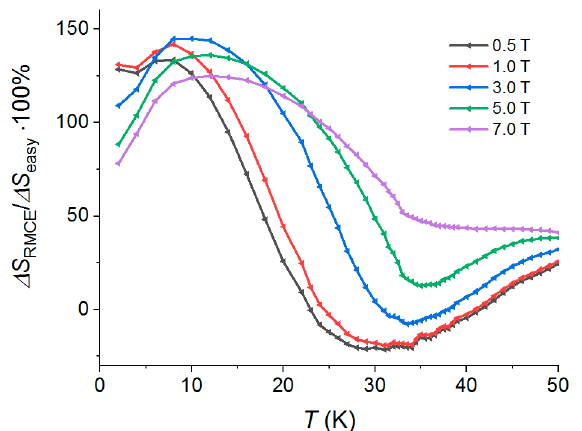
Figure 33. Percentage ratio between ∆ S RMCE and ∆ S easy (easy plane) for 11 as a function of temperature for different fields. Adapted with permission from Reference [71] Copyright 2017 American Chemical Society.